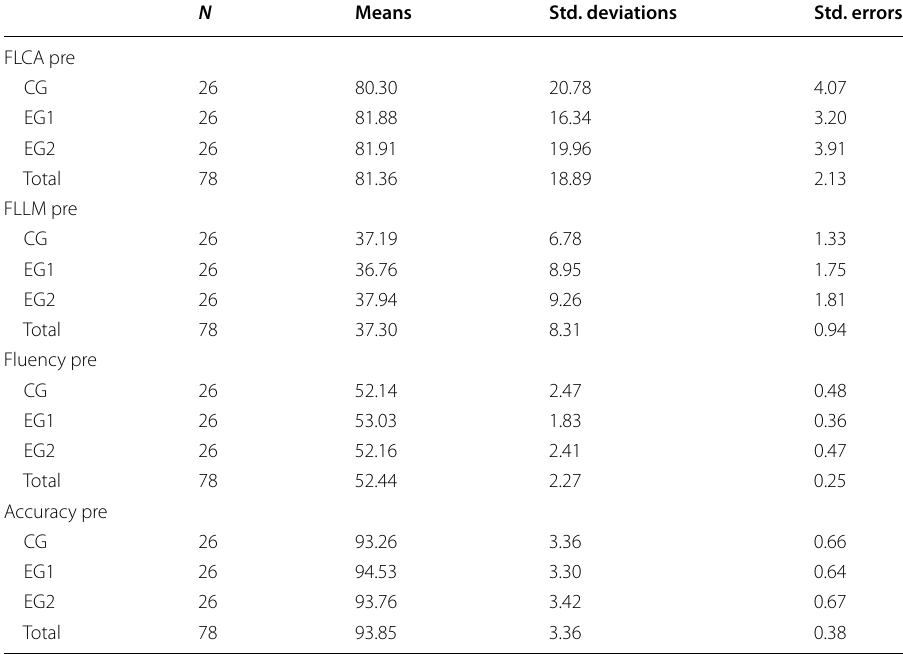
Table 1 Means and standard deviations in pre-tests of SAF, FLCA, and FLLM of CG, EG1, and EG2 N Means Std. deviations Std. errors